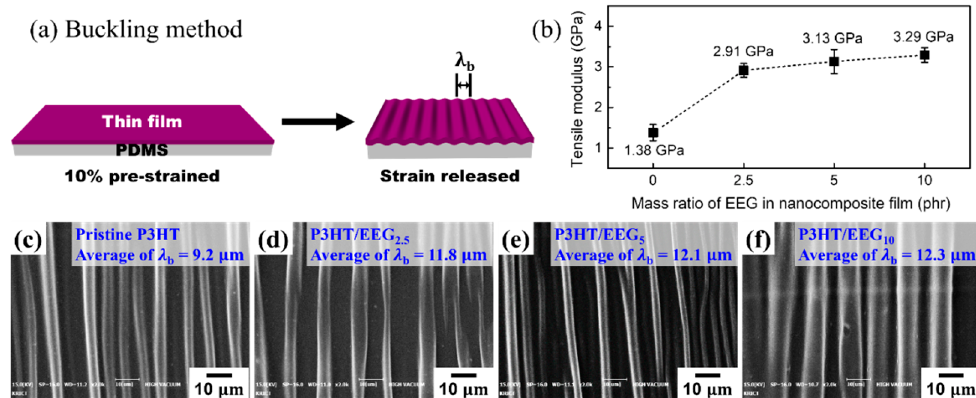
Figure 6. ( a ) Schematic illustration of buckling method. ( b ) Tensile modulus and ( c – f ) SEM images of buckling waves on transferred P3HT and the P3HT/EEG nanocomposite films.